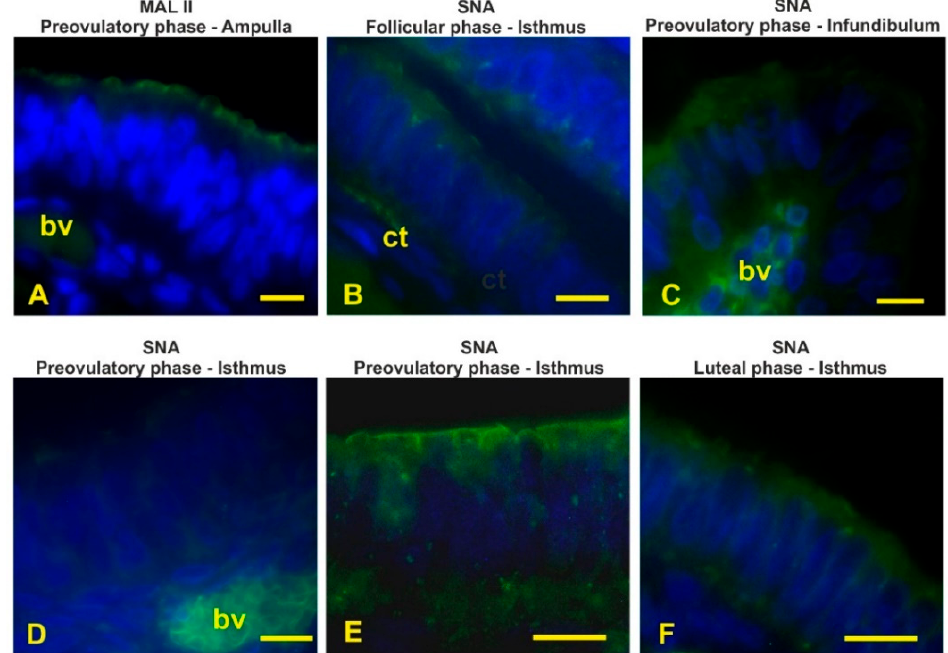
Figure 11. Direct detection of sialic acids with MAL II ( A ) and SNA ( B – F ) in the baboon Papio ham-